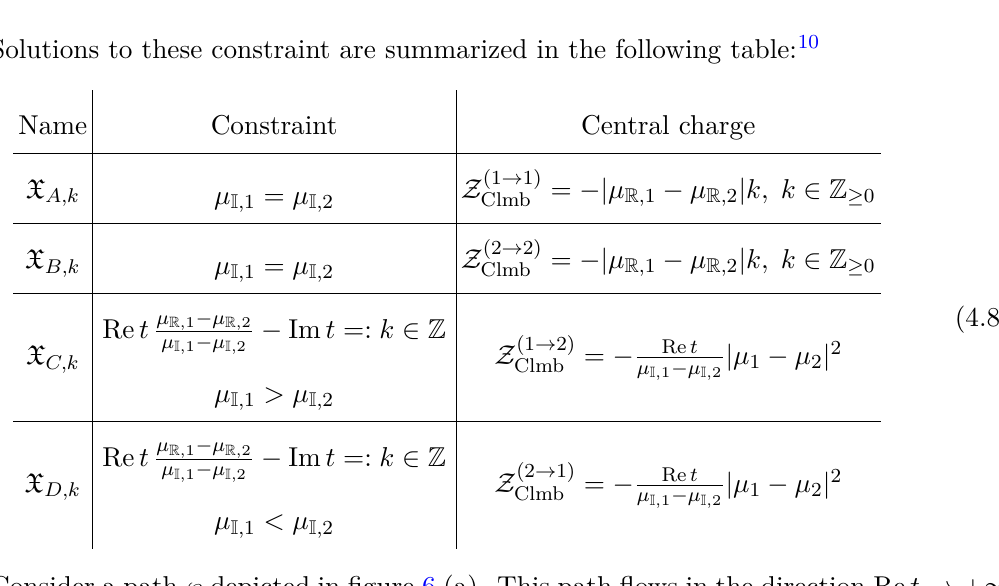
Figure 7 . Equivariant CP 1 vacua positions in W